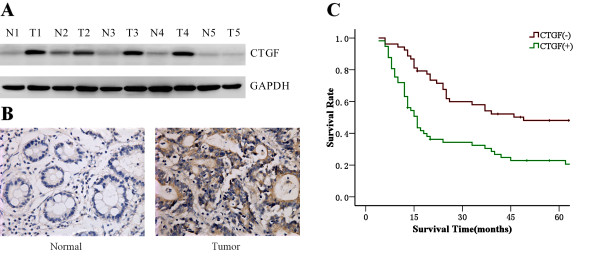
Overexpression of CTGF in gastric cancer with worse prognosis. A. Western blot analysis demonstrated the CTGF expression in gastric cancer tissues and matched distal normal tissues from five randomly selected gastric cancer patients. B. Immunohistochemistry results of CTGF expression in paired gastric cancer tissue samples. C. Kaplen-Meir survival curves for 110 patients with gastric cancer, grouped according to CTGF expression.